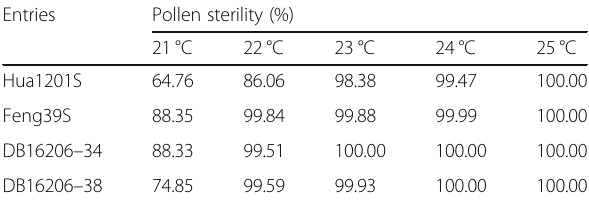
Table 4 Fertility-sterility alternation behavior of two selected PTGMS breeding lines and parents under five temperature regimes in growth chambers with 14-h light duration